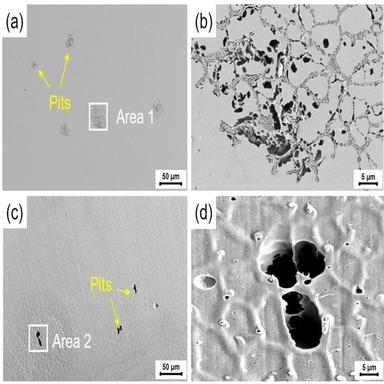
Corrosion morphologies of the pure (a) SS431 and (c) SS316L parts after potentiodynamic polarization in 3.5 wt.% NaCl solution using the SDC test system; (b) and (d) are magnified view of area in (a) and (c).